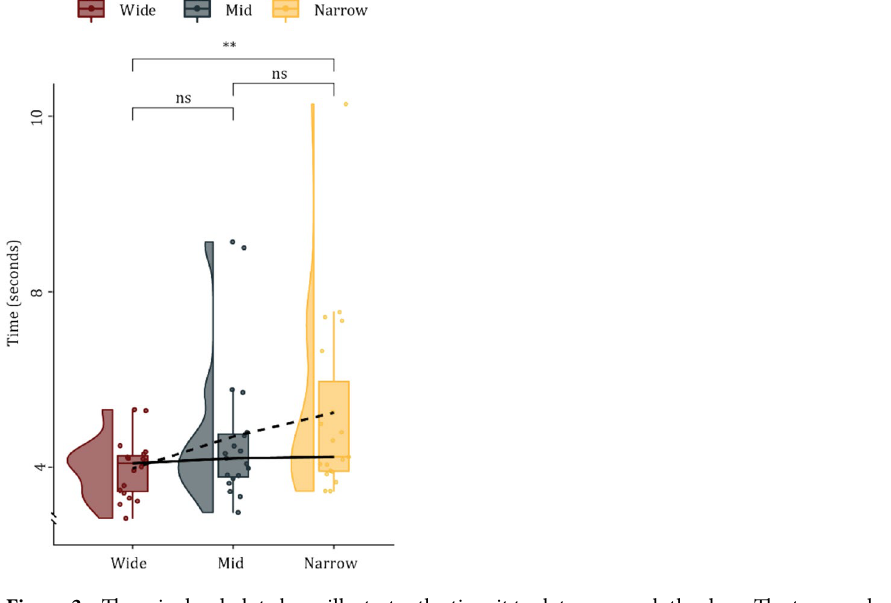
Figure 3. The raincloud plot above illustrates the time it took to approach the door. The temporal measure appears in seconds for each condition, i.e. door size. Means are represented by the dashed line, while the medians by solid lines. The statistical measure is the Tukey HSD; all p > .05 are written as ‘ns’, and all p < .01 are written **.